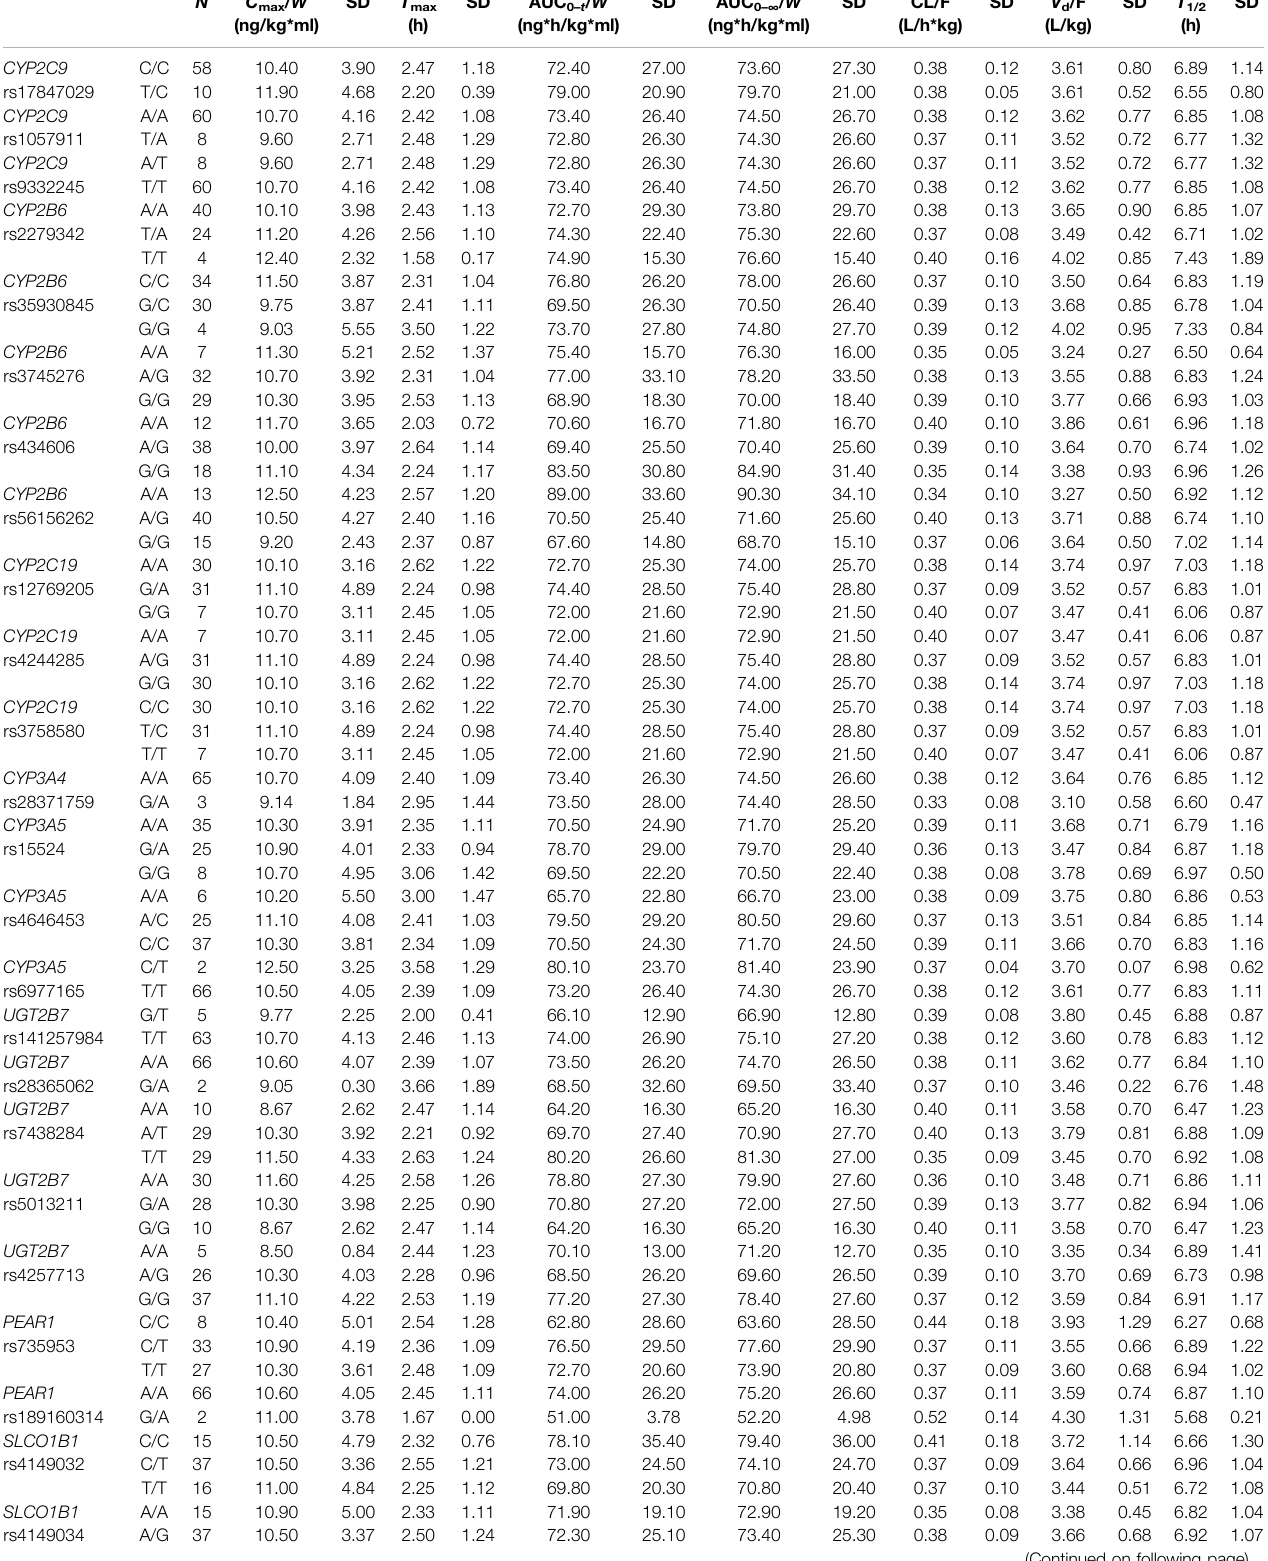
TABLE 4 | Ticagrelor pharmacokinetic parameters based on genotypes without statistical signi fi cance